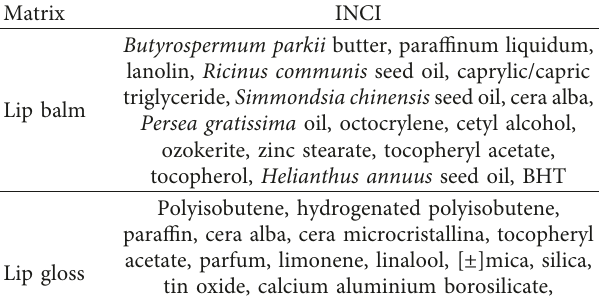
Table 5: INCI for the matrices used for